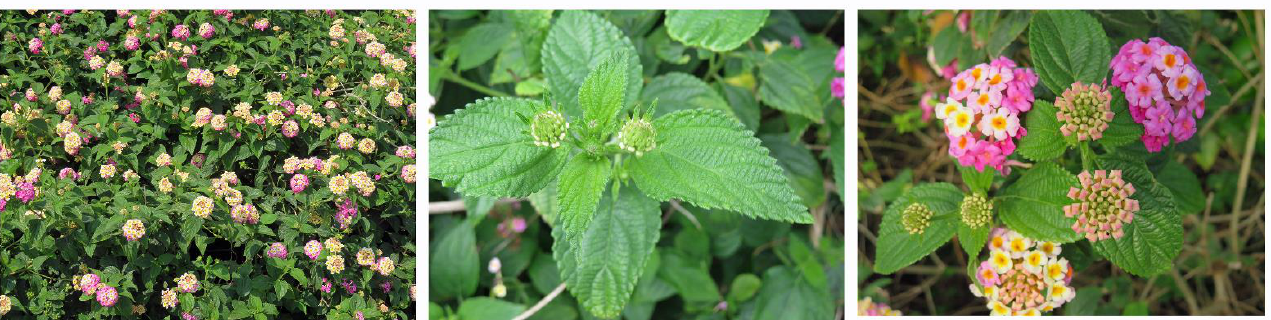
Figure 1. Lantana camara . Photos were taken by Kato-Noguchi.